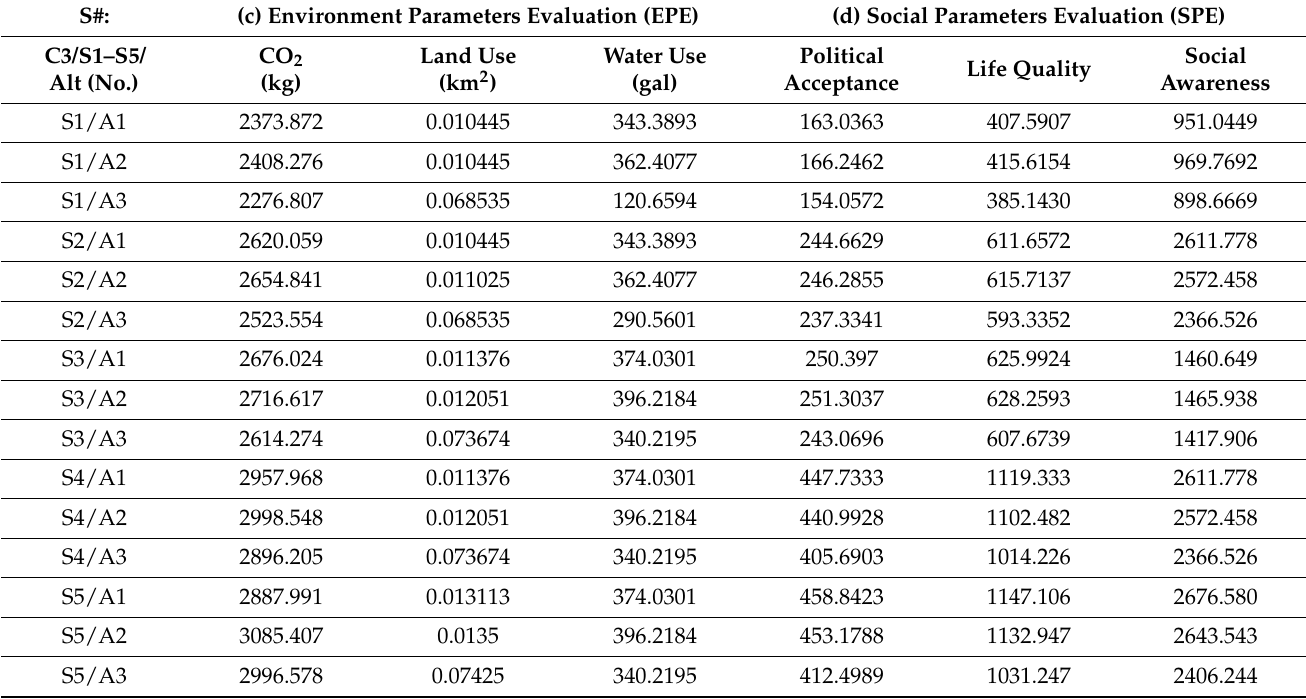
Table 15. EPE/SPE evaluations in C3/S1–S5 for the 65-bus MDN NUST_MG for DG